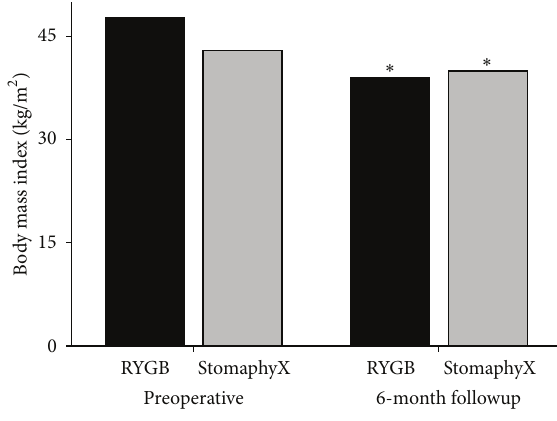
Figure 2: Comparison of initial body mass index and at 6-month followup in VBG patients revised by RYBG or endoscopically (StomaphyX). ∗ 𝑃 < 0.05 versus preoperative body mass index. Table 2: Complications following VBG revision by either Stoma- phyX or